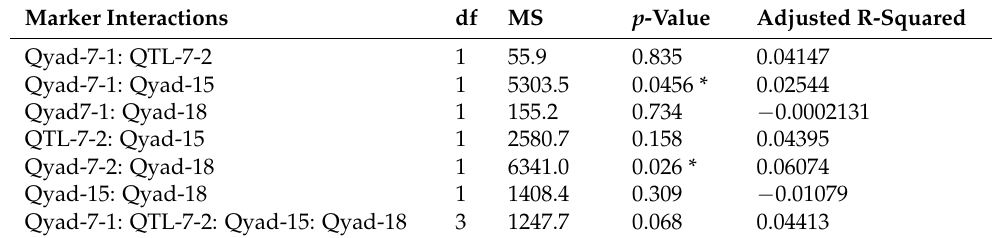
Table 4. Interactions among the detected QTL.